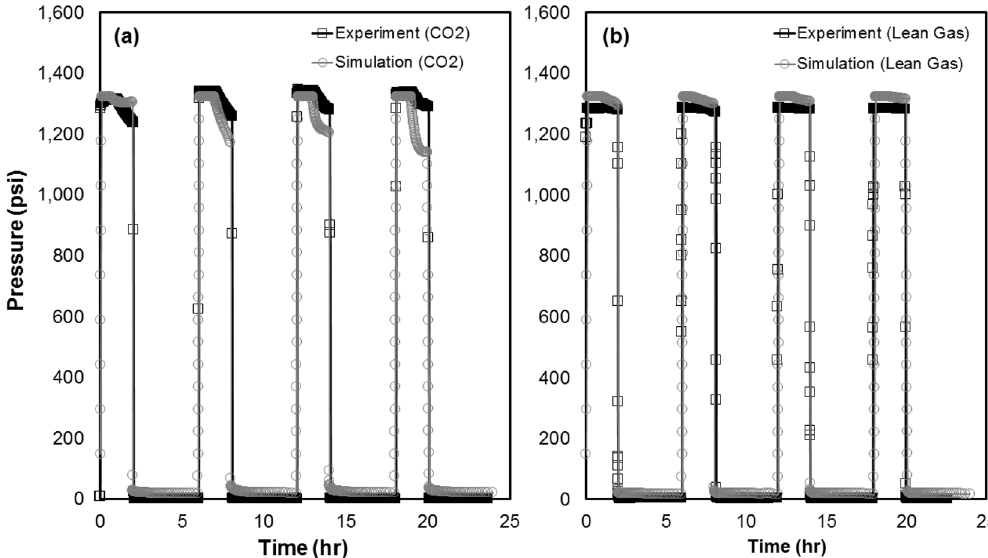
Figure 6. Comparison between experimental and simulated pressure decay profiles for CO 2 (a) and lean gas (b) .